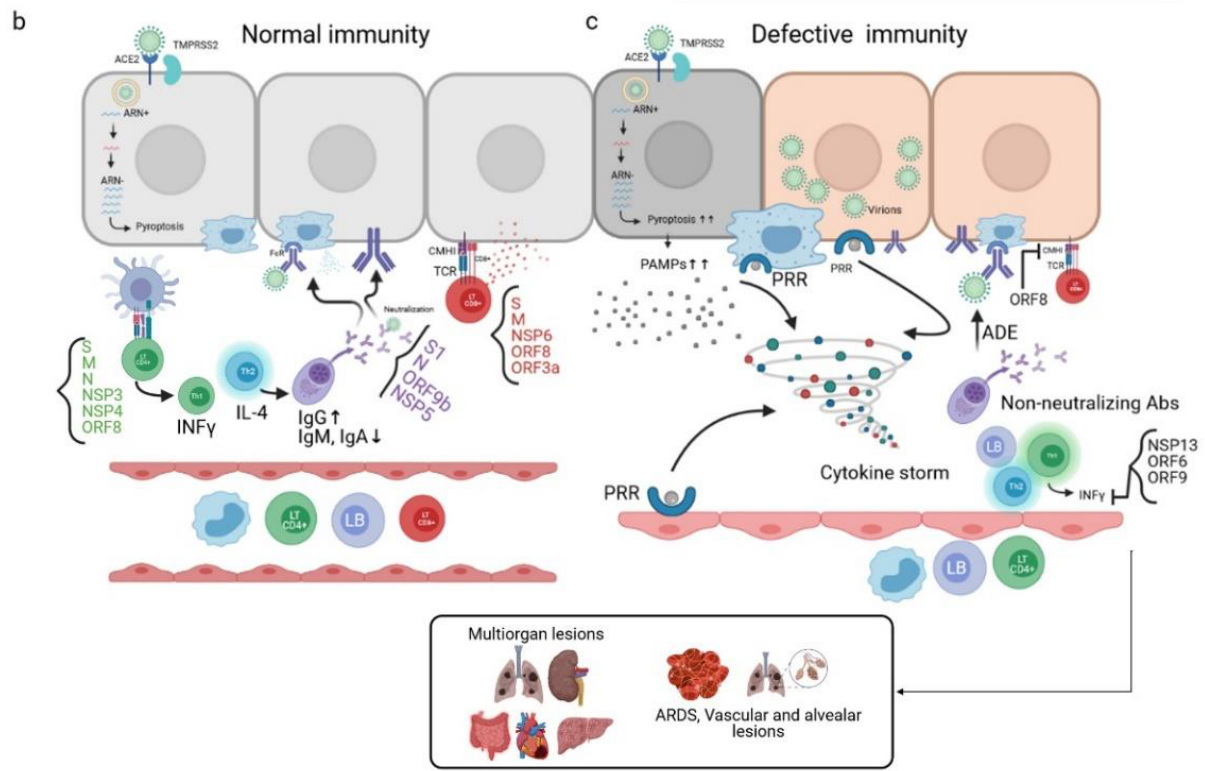
Figure 5. Mechanism of the immune response during SARS-CoV-2 infection. ( a ) SARS-CoV-2 penetrates the host cell by endocytosis through the Spike binding to the ACE2R present in alveolar epithelial cells. The active replication of the virus and the release of virions lead to pyroptosis, and, therefore, the release of pathogen-associated molecular patterns (PAMPs) recognized by pattern recognition receptors (PRRs) of neighboring alveolar epithelial cells, alveolar macrophages, and endothelial cells. This leads to the production of pro-inflammatory cytokines/chemokines, which in turn attract other immune cells to the infection site. ( b ) In the case of a normal immune system, CD4 + LTs recognize antigen-MHCII complexes of antigen-presenting cells (APCs). This induces the differentiation of CD4 + LTs into Th1, which is the producer of INF γ . CD4 + LTs can also differentiate into Th2, the producer of IL-4, which activates the LBs into plasma cells that produce neutralizing antibodies; these antibodies target several virus antigens and promote viral phagocytosis through the opsonization phenomenon. The CD8 + LTs recognize the antigens presented by the infected cells through the interaction of their TCRs with the CMHI of the infected cells, thus leading to cell death by cytotoxicity. ( c ) In the case of a defective immune system, a high level of pyroptosis induces a cytokine storm; non-neutralizing antibodies are produced, which are responsible for the antibody-dependent enhancement (ADE) phenomenon. In addition, inhibition of the production of INF γ occurs due to the involvement of certain viral proteins responsible for immune escape. This unbalanced immune response leads to multiorgan lesions, acute-respiratory-distress-syndrome (ARDS), and alveolar and vascular lesions [7,57]. (Designed by